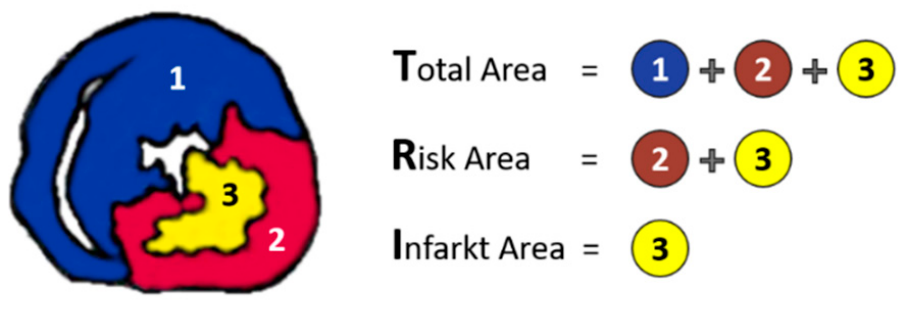
Figure 2. Schematic representation of the heart section with the measured areas. T = total area of the section, R = area at risk (area perfused by the LAD) and I = infarct area.